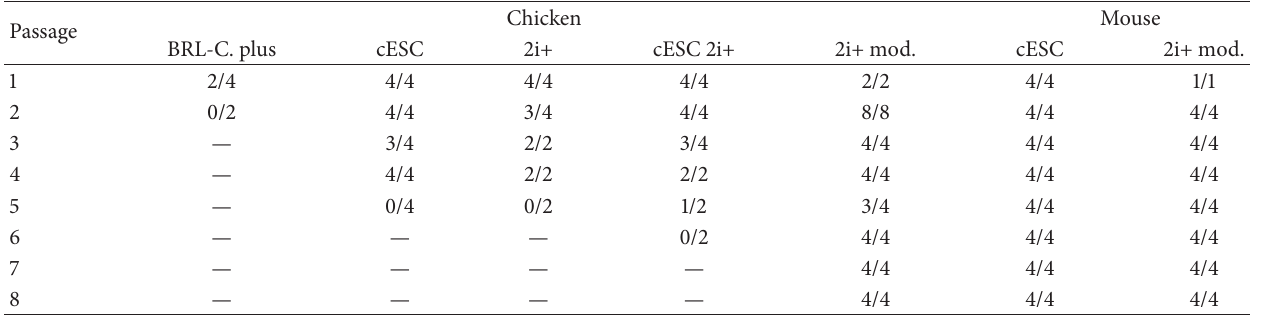
Each row indicates a passage from the previous row. The numerator of the fraction indicates the number of cultures (wells/plates) that survived the passage, and the denominator represents the number of cultures started in that passage. A “—” sign indicates that no cells survived to make it to that passage. During each passage, if the cultures were highly proliferative, each well or plate of cells was expanded into 4 other wells/plates; if they had a low level of proliferation, they were only expanded to 2 others; if they were not proliferating, they were necessarily passaged undiluted from one well to another until the cells senesced. The denominator of the cell immediately inferior indicates the ratio at which the cells were split. We tried increasing or decreasing cell concentration for those cultures that stopped proliferating, but this did not prevent them from senescing. The chicken iPSC-like cells in our modified 2i+ media (2i+ mod.) and our own mouse iPSC in KO-DMEM media have both made it past 20 passages (not shown).